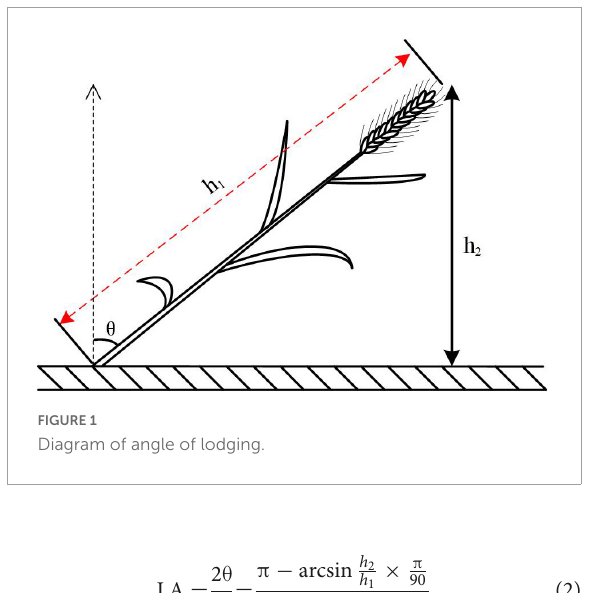
FIGURE1 Diagram of angle of